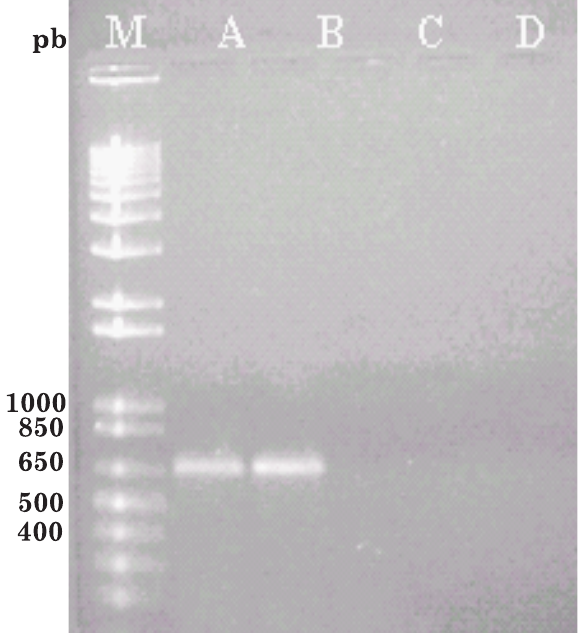
Figura 2. Eletroforese em gel de agarose 1,5 % do fragmento de amplificação da PCR com os primers ITS1 e ITS4 do fungo Scleroderma UFSMSc1. M - Marcador molecular 1 Kb Plus DNA Ladder, Gibco, A e B - Amostra contendo produto PCR do Scleroderma UFSMSc1, C e D - Amostra controle, pb - Pares de bases. Santa Maria, RS,